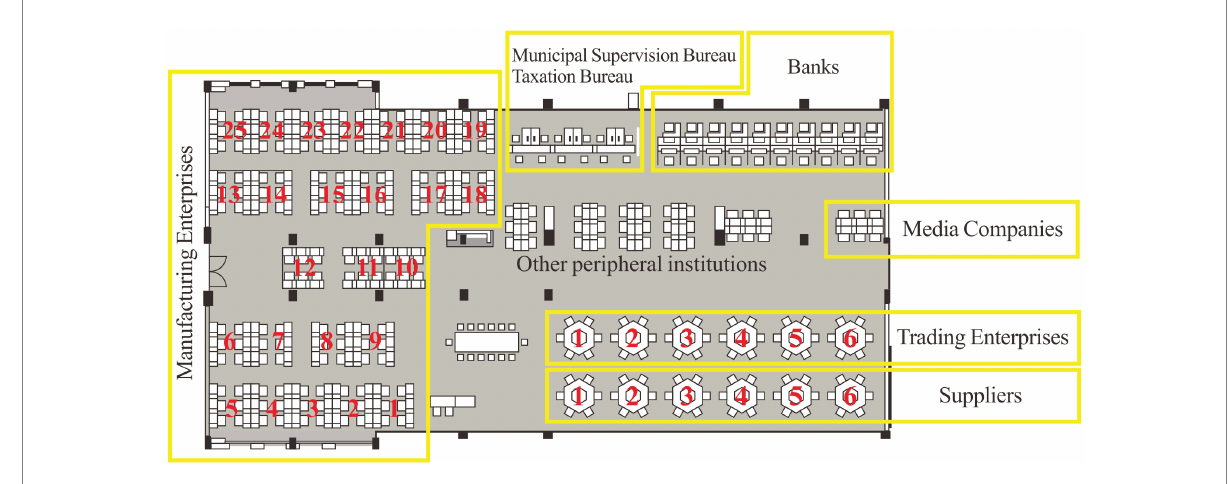
FIGURE 4 Classroom floor plan, main functional areas, and workstation